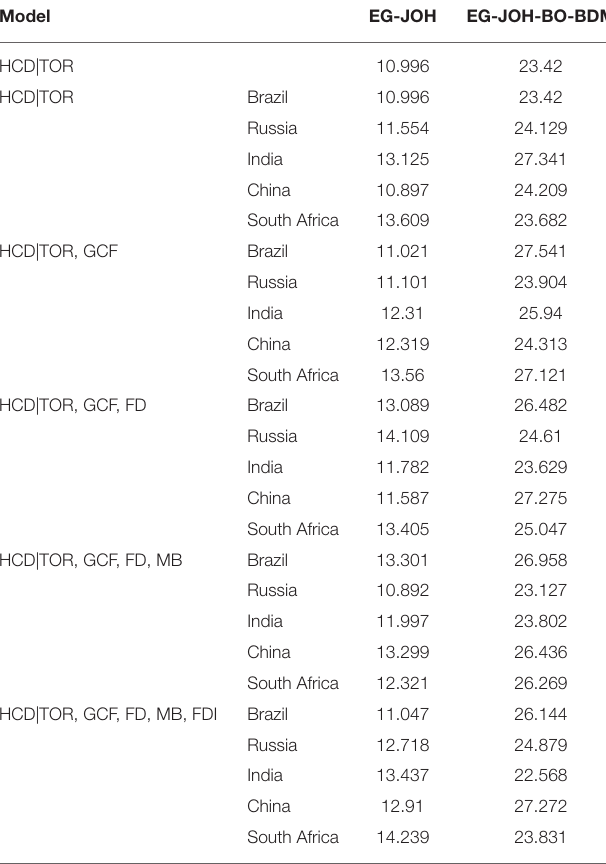
TABLE 5 | Results of Bayer–Hacked combined counteraction test.